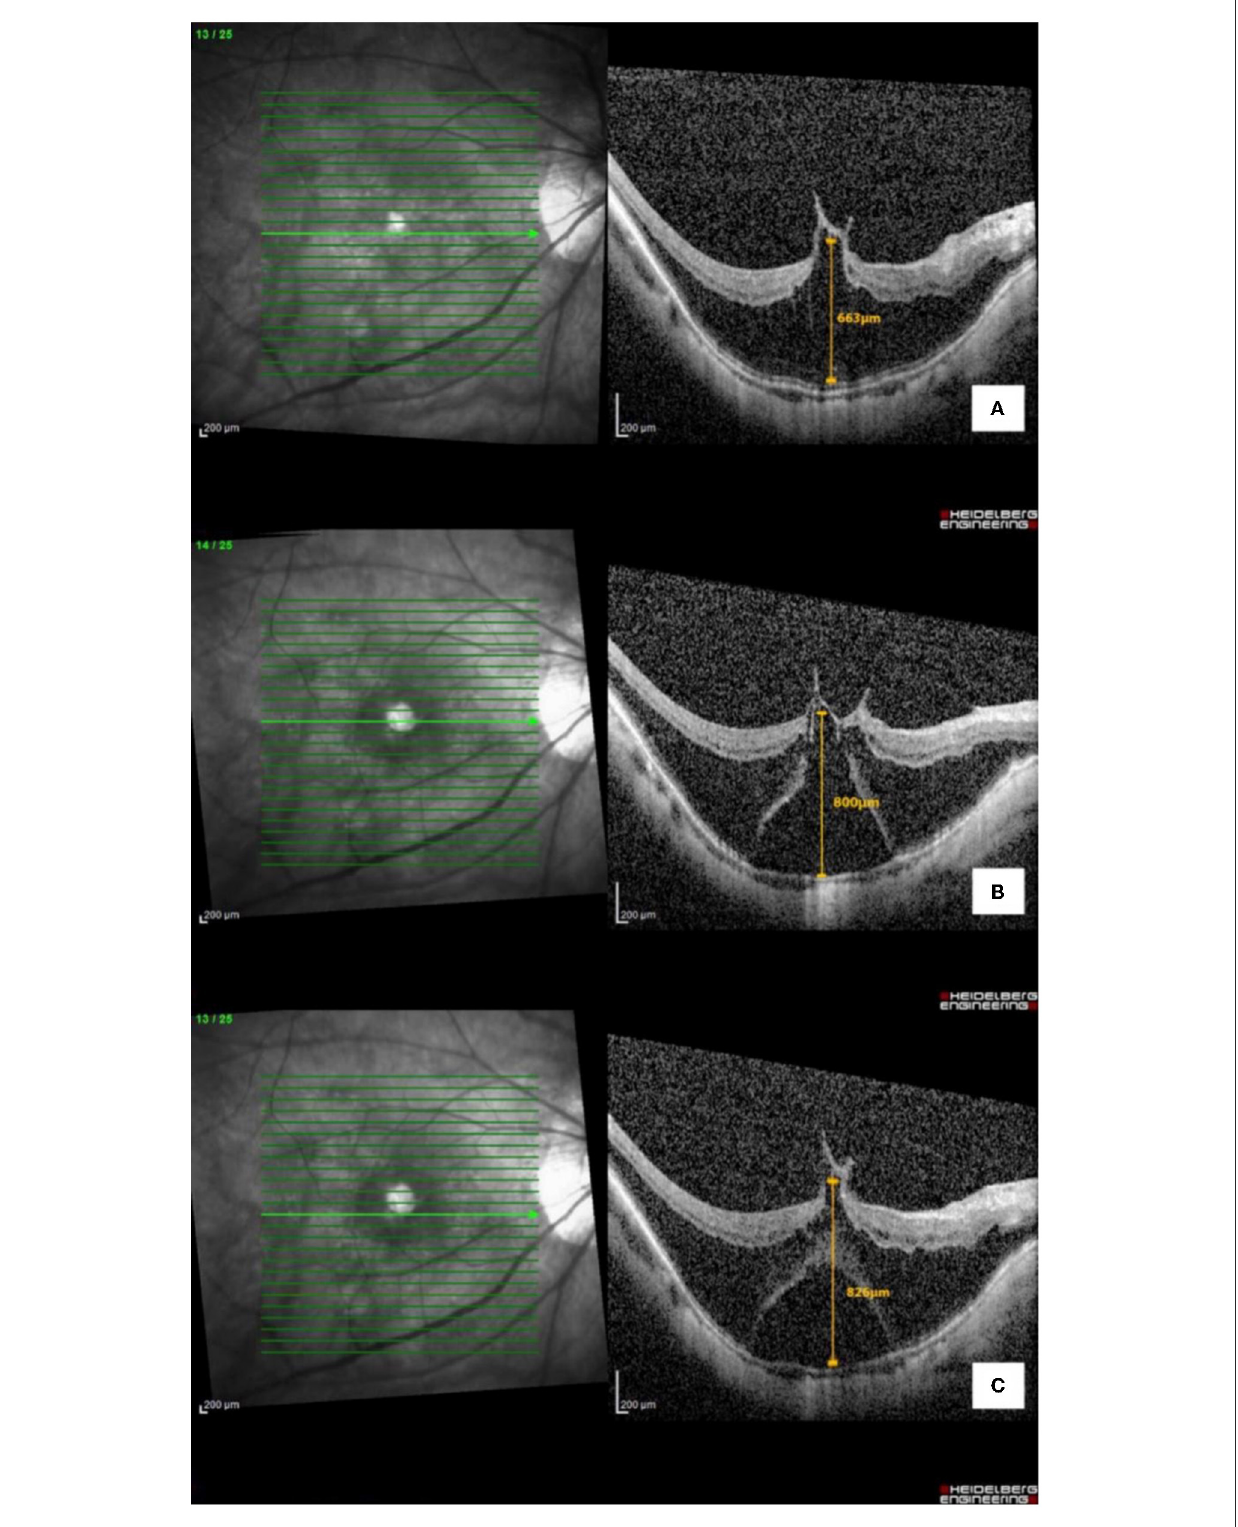
FIGURE3 Optical coherence tomography macula of the right eye with (A) myopic foveoschisis with vitreomacular traction pre-operatively, (B) myopic foveoschisis with new-onset outer lamellar macular hole, and (C) macular detachment post-cataract